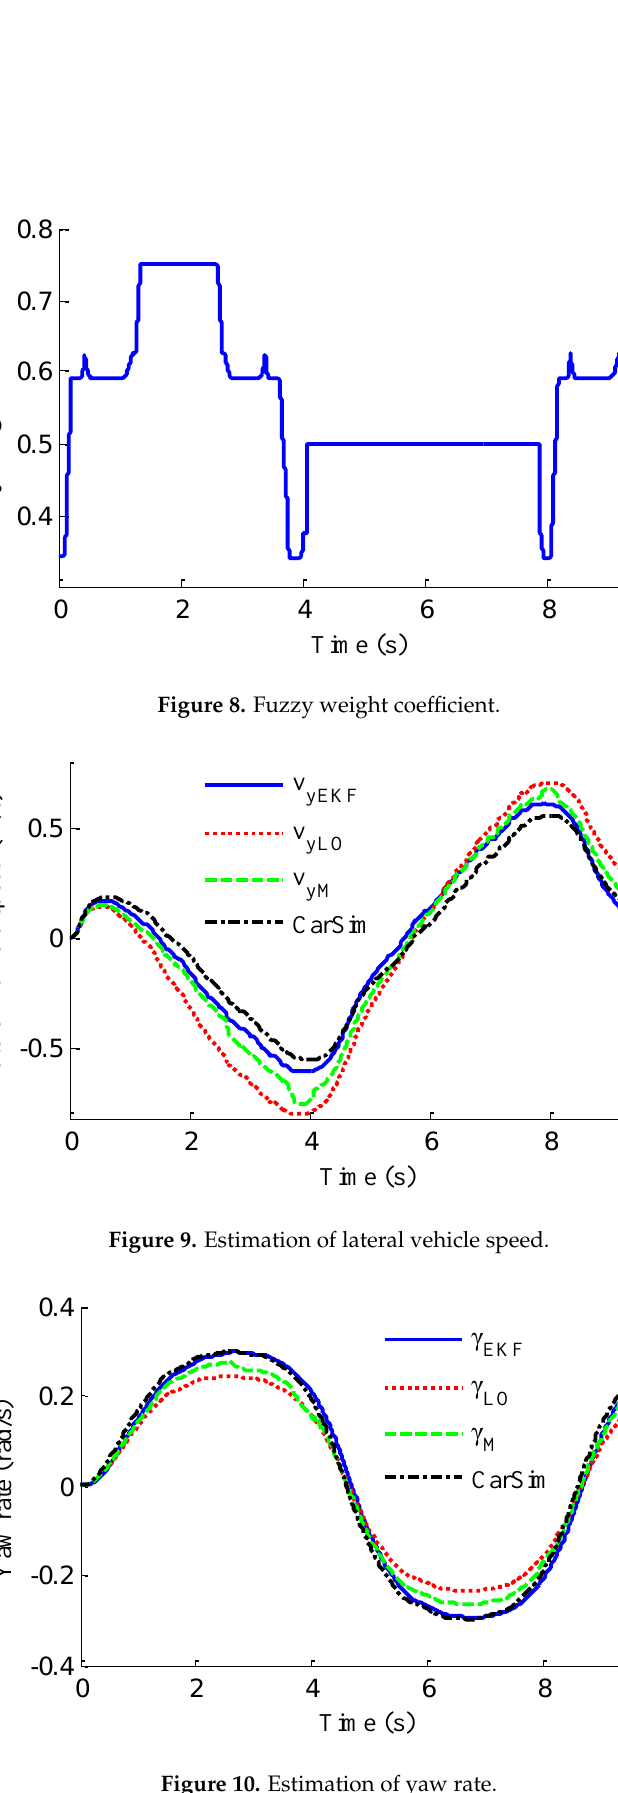
Figure 10. Estimation of yaw rate.